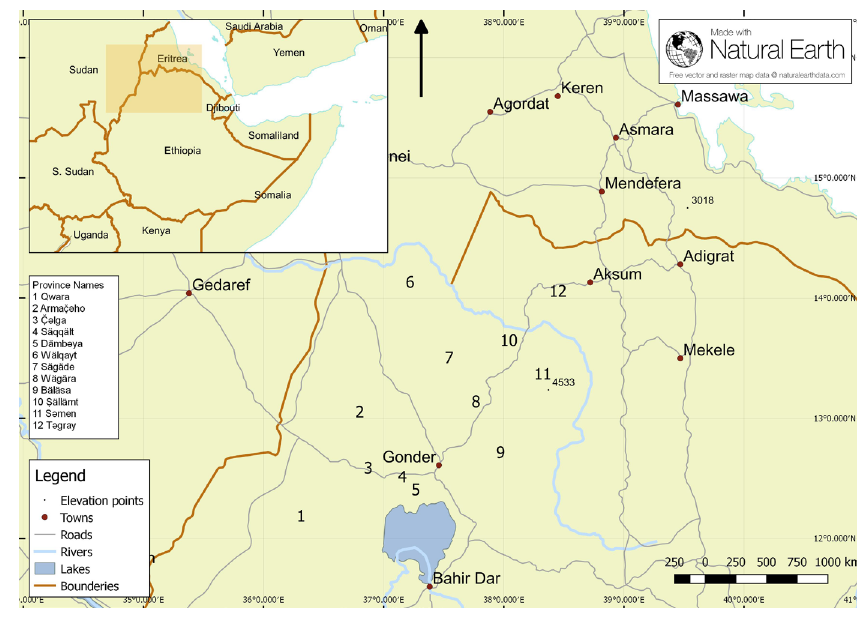
FIgure 1 Areas inhabited by the Beta Israel in pre-modern times. Made with Natural Earth (Free vector and raster map data @